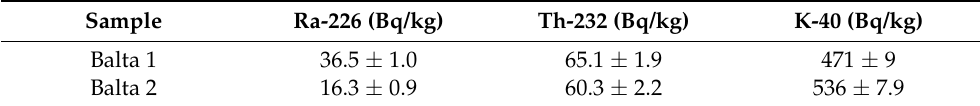
Table A4. Radionuclide specific activity results.